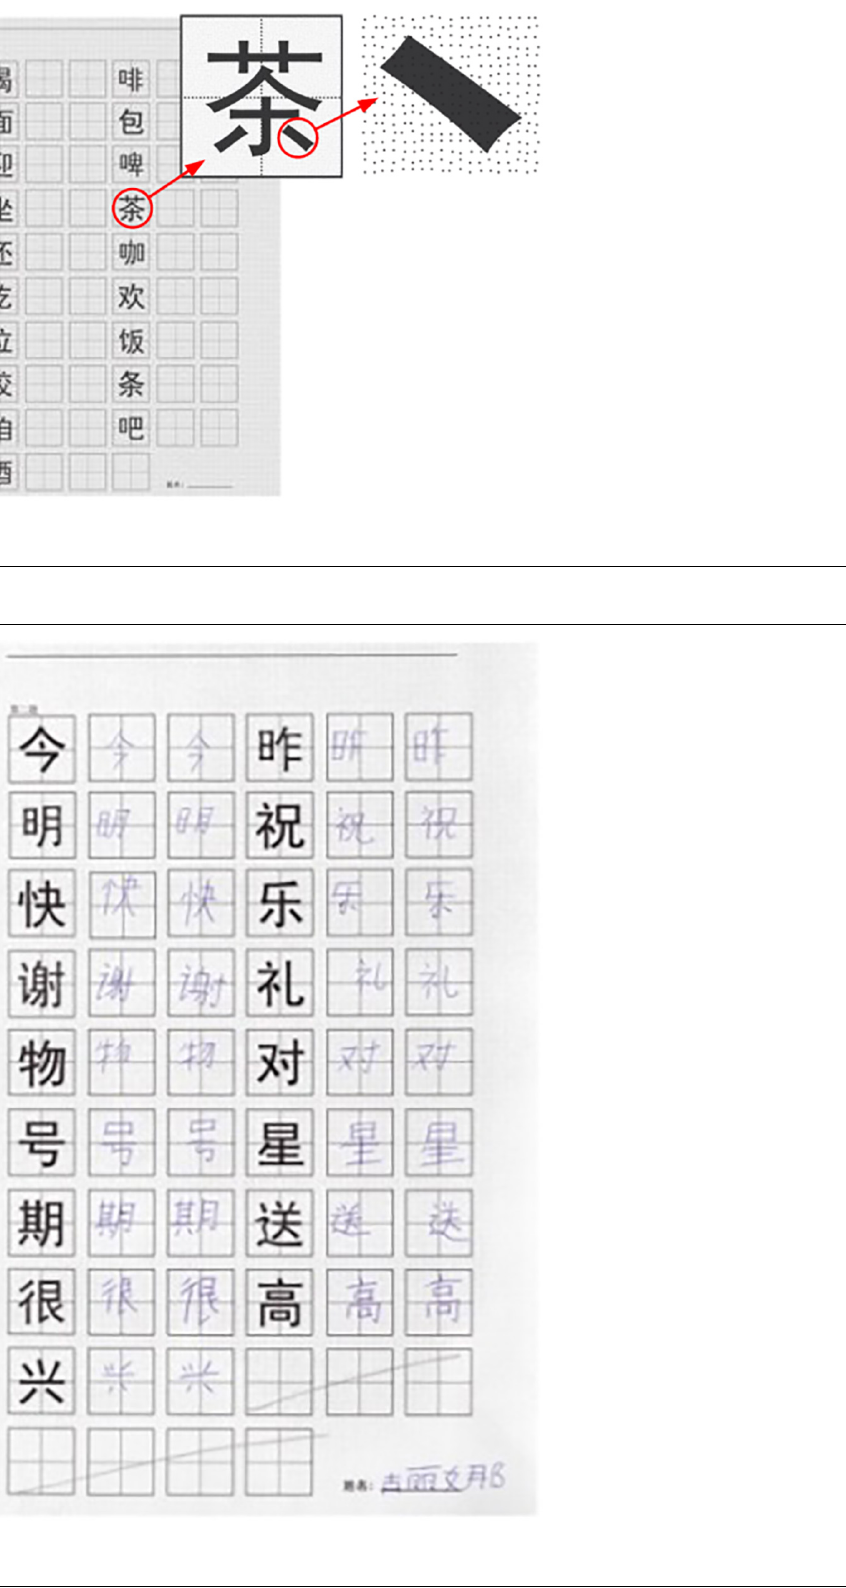
FIGURE 2 | Handwriting